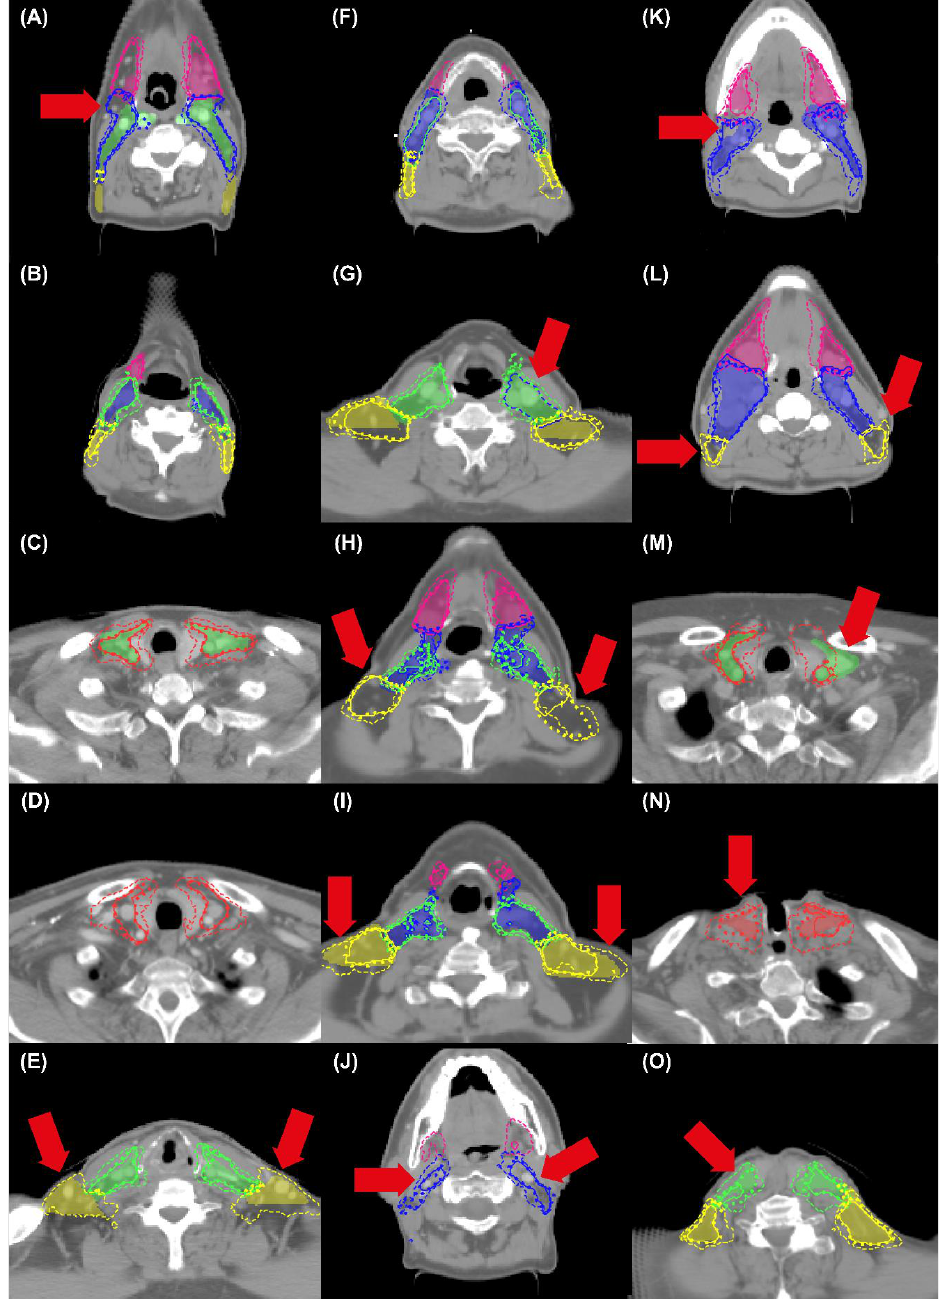
Figure 6. Examples from the worst-performing quartile samples in terms of DSC averaged over individual LN levels I–V. The filled region is the manual reference. The solid, dashed and dotted lines correspond to the predictions of the UNet, MV and UNet+MV model configurations, respectively. LN levels I–V are indicated in pink, blue, green, red and yellow, respectively. Arrows indicate specific locations of interest. Abbreviations: DSC: dice similarity coefficient; LN: lymph